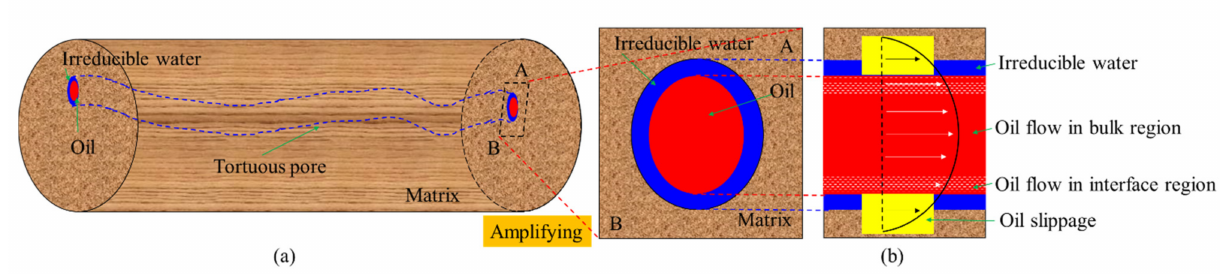
Figure 1. Schematic representation of oil flow in tight reservoirs: ( a ) oil flow in a core with numerous tortuous pores; ( b ) oil velocity profile in a pore considering the effects of multiple factors, including oil slip, irreducible water, and the effect of the